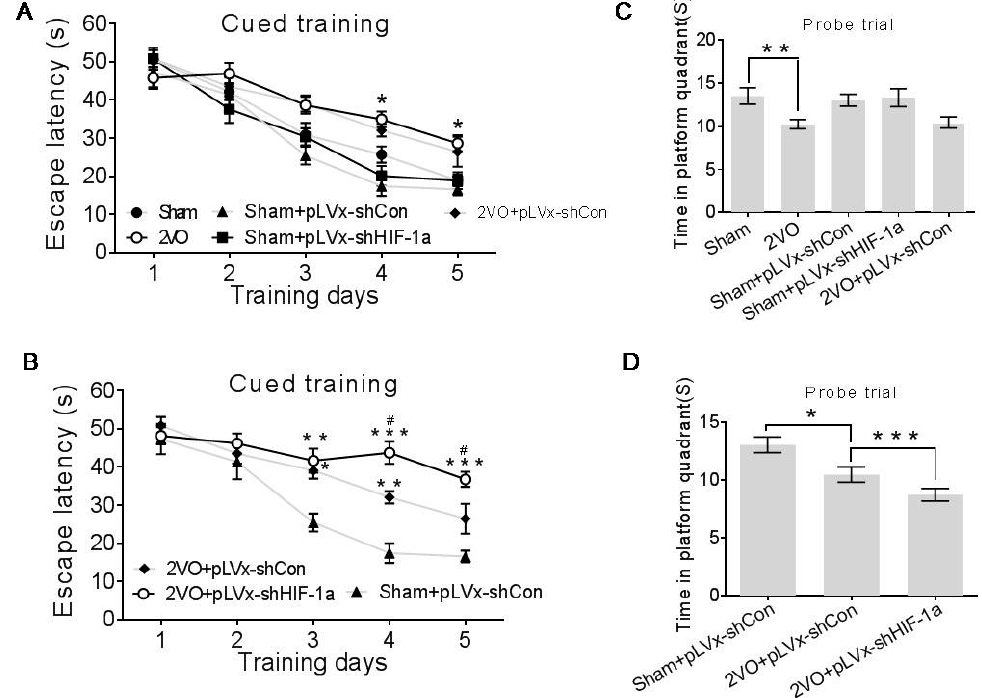
Figure 3. The effects of HIF-1 α knockdown on CCH-induced deficits in spatial learning and memory